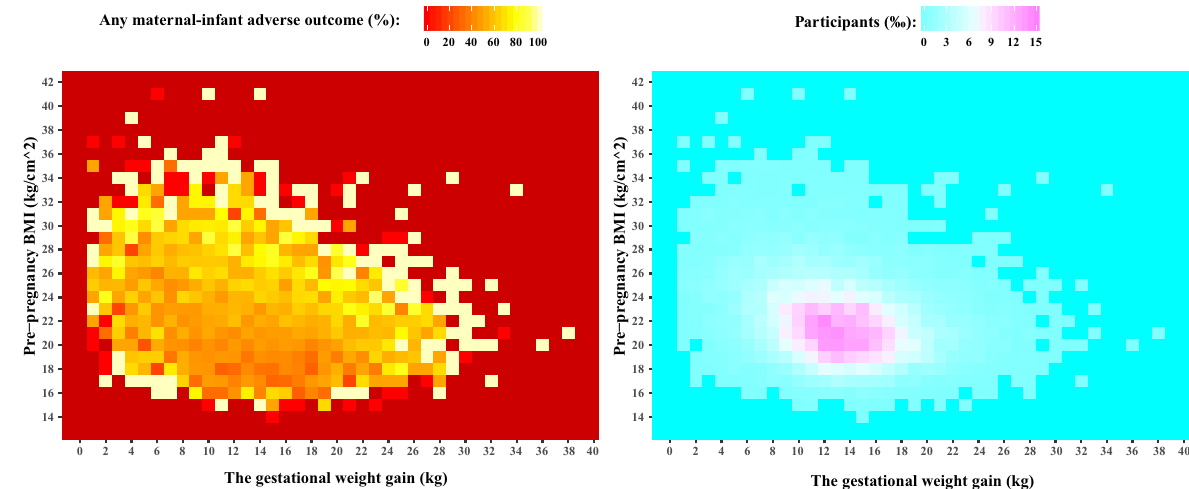
Figure 2. The risk heat map of the maternal-infant adverse outcomes. ( a ) Values represented the risks of any maternal-infant adverse outcomes. ( b ) The percentages of participants for each combination of BMI and GWG.